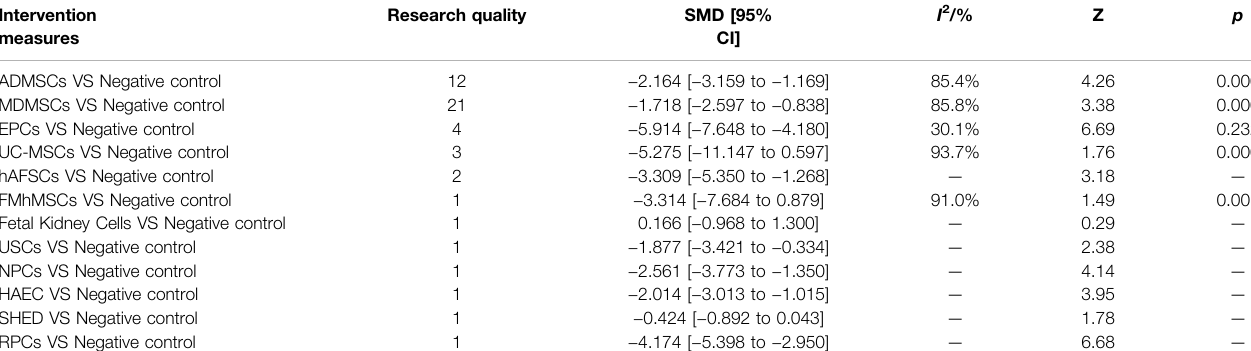
TABLE 1 | Traditional Meta-analysis results of serum creatinine levels between stem cell groups and the control group at 1 day after administration. Intervention measures